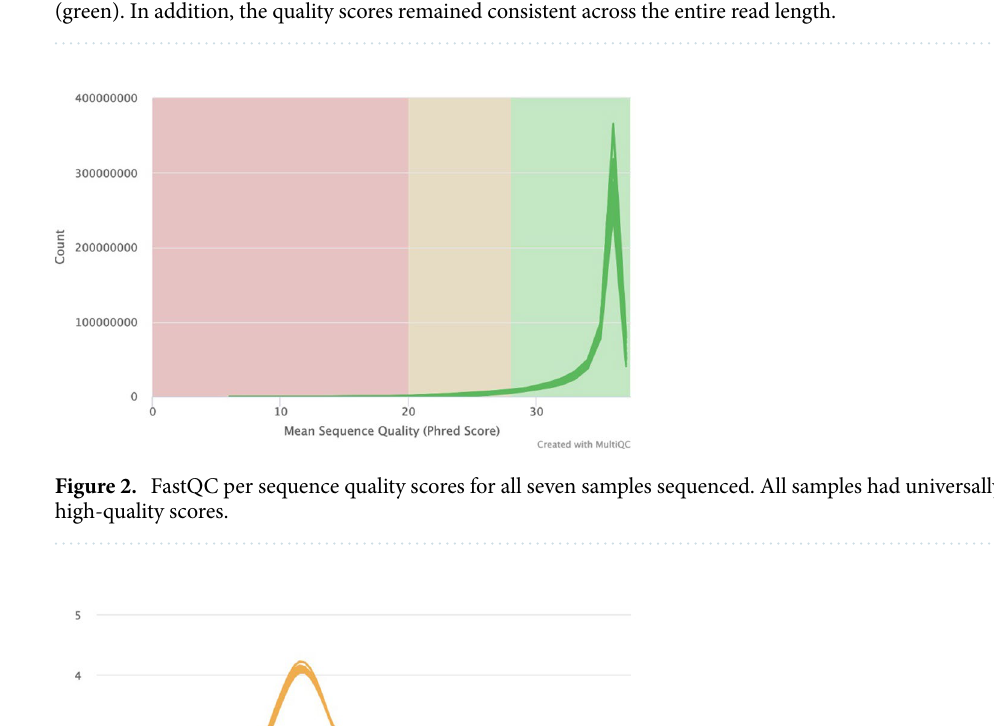
Figure 1. FastQC mean quality scores . FastQC quality scores for all seven samples were obtained. The higher the phred score, the better the base call. For all seven samples, bases for all samples were considered high quality (green). In addition, the quality scores remained consistent across the entire read length.